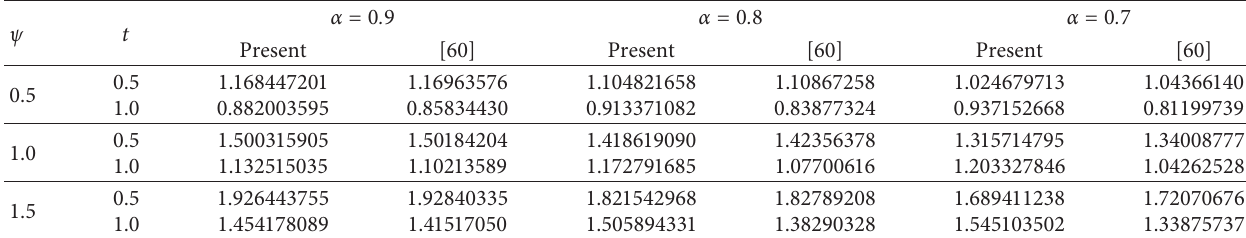
Table 2: Approximate solutions for different values of α for equation (1).